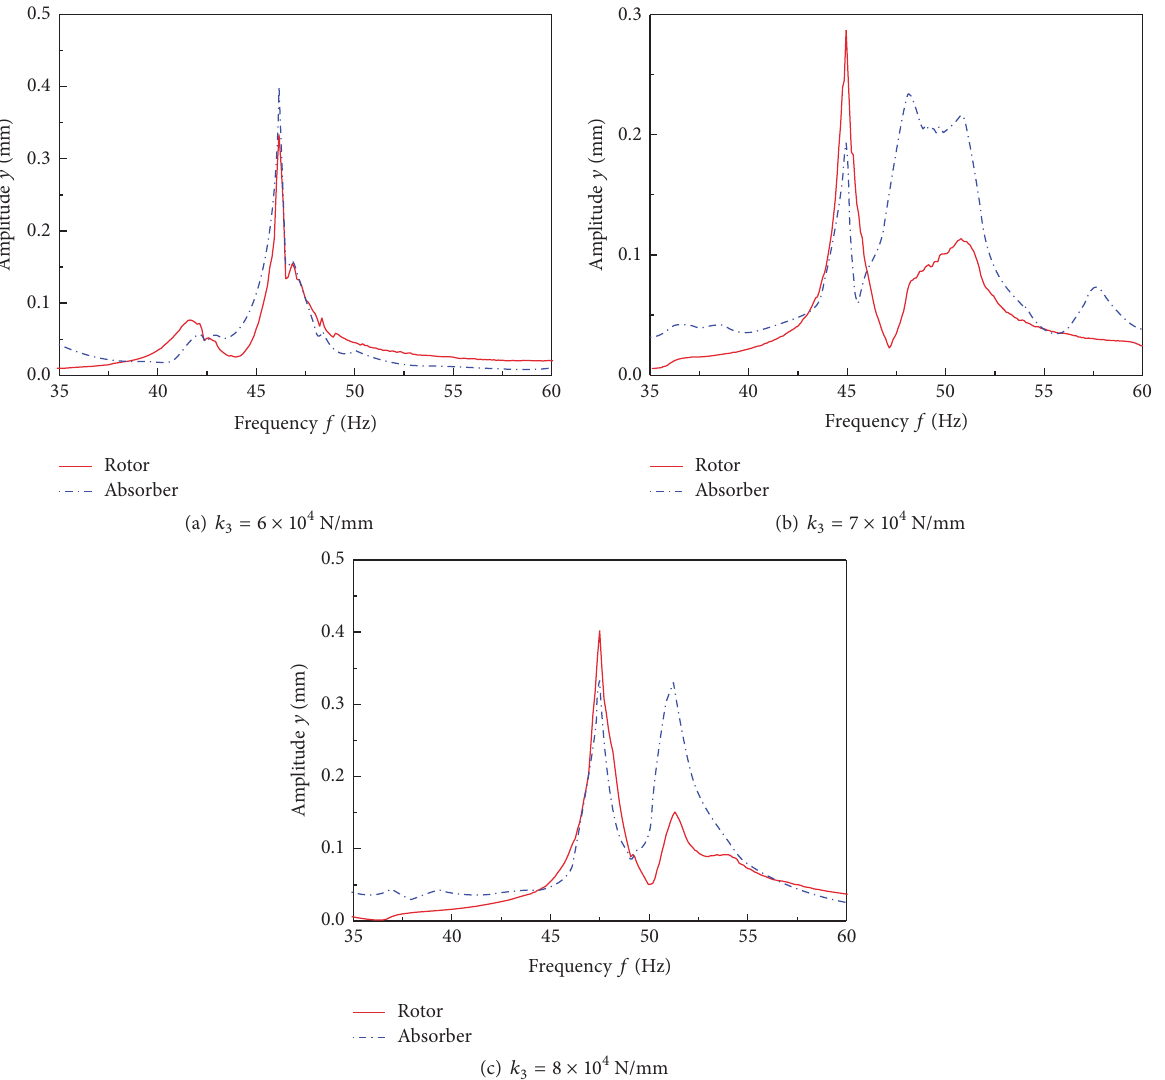
Figure 13: Responses of the rotor-absorber system with different 𝑘 3 when ℎ is